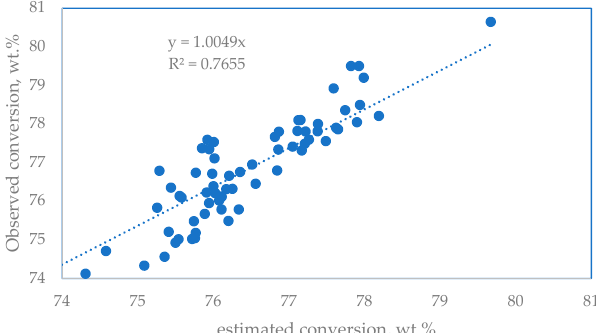
Figure 5. Parity graph of conversion estimated by Equation (1) versus observed conversion at the LNB FCCU.